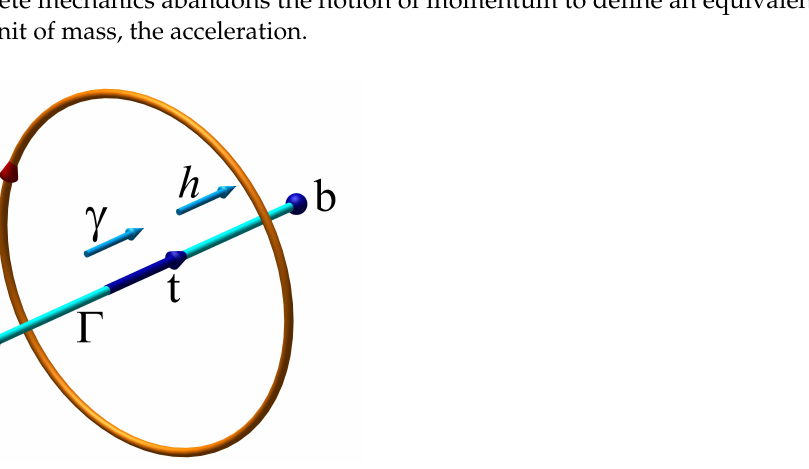
Figure 1. Local frame of reference of discrete mechanics; the rectilinear segment Γ oriented by t is the constitutive element of the primal structure and the support of the intrinsic acceleration γ or imposed by the exterior h . This segment, limited by its extremities a and b , is of length dh and called the discrete horizon. The dual structure is schematized by the contour ∆ , which defines the induced actions then projected on Γ